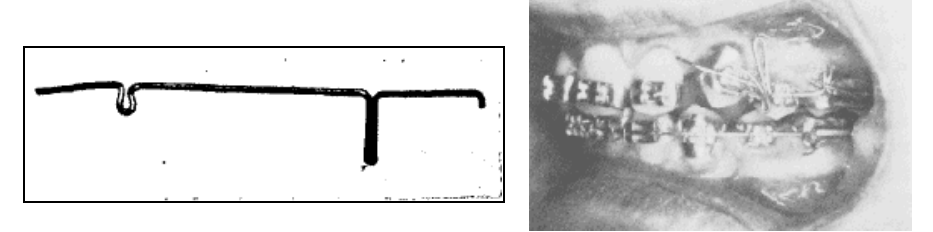
Figure 3: Canine retraction using Bull